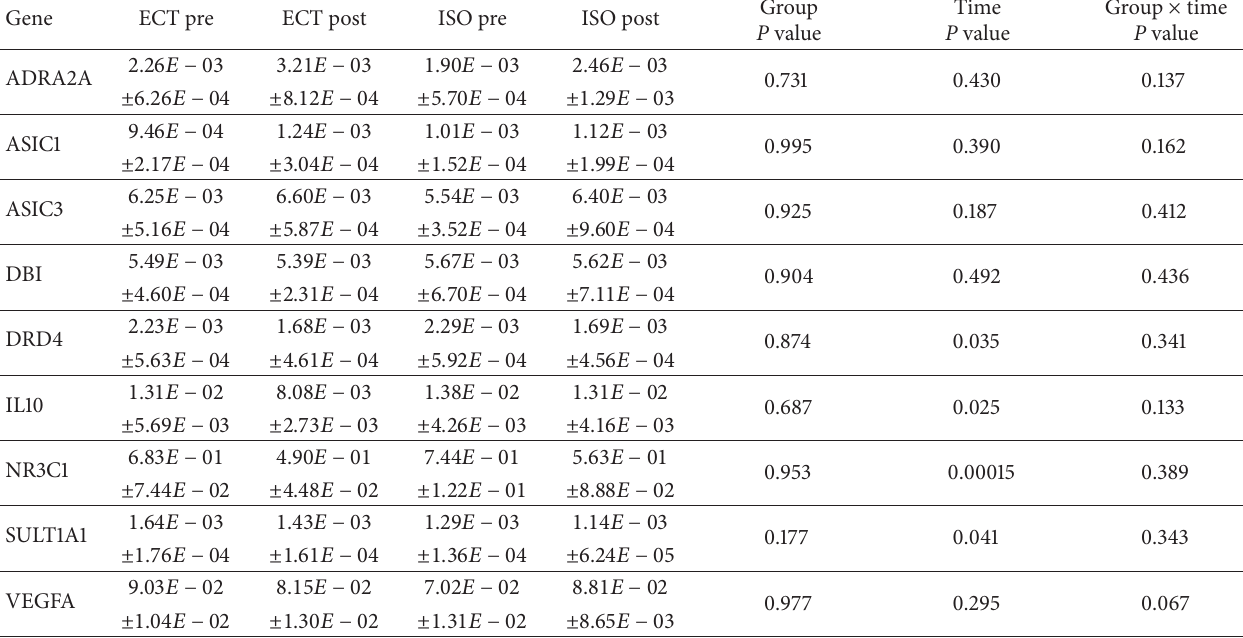
Table 3: Gene expression for all 9 target genes at pretreatment versus posttreatment: means and ANCOVA outcomes for effects of treatment group (ECT versus ISO), sample time (pre- versus posttreatment) and group × time